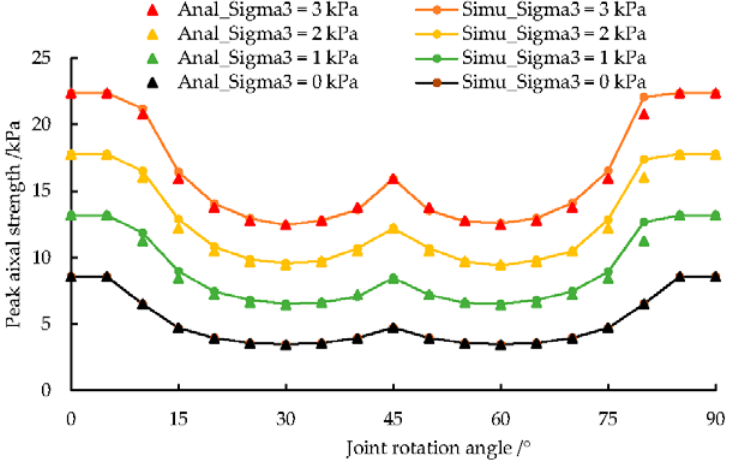
Figure 17. Peak strength versus orientation of joint system under various confining pressures.